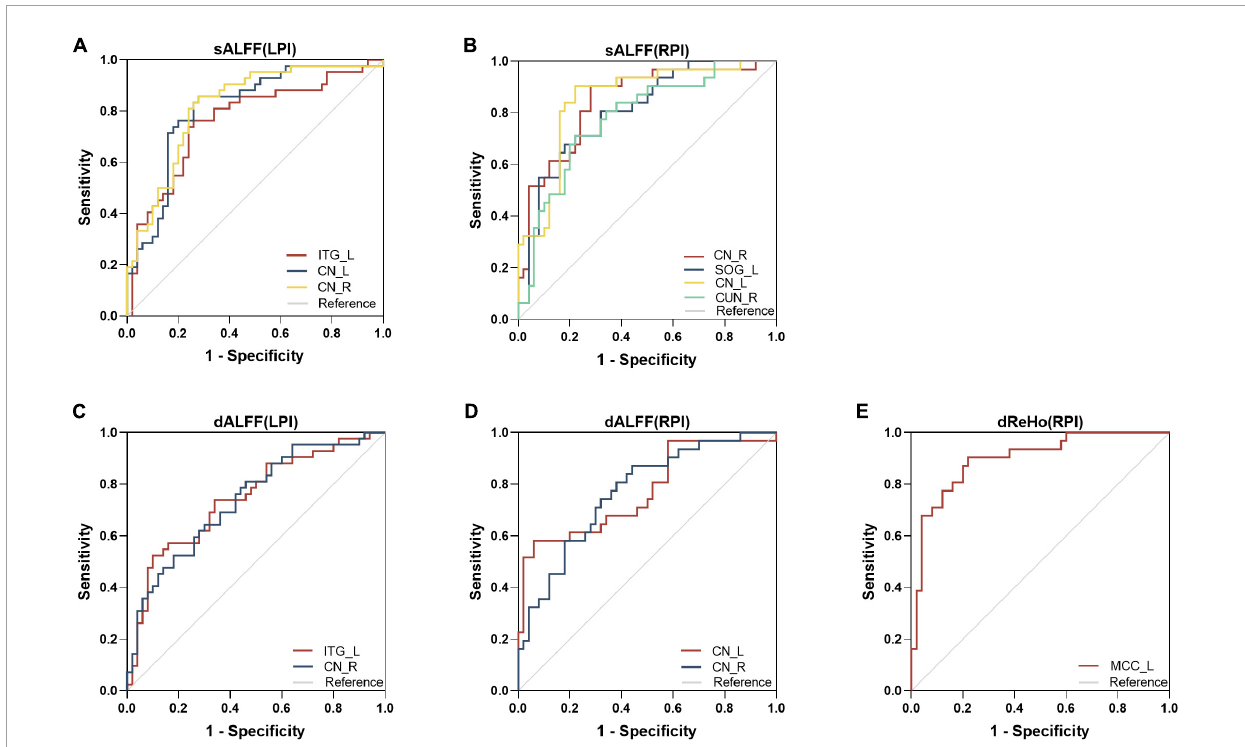
FIGURE5 Receiver operating characteristic (ROC) analyses of sALFF (A,B) , dALFF (C,D) , and dReHo (E) in the defined region of interests (ROIs). dALFF, dynamic amplitude of low-frequency fluctuations; dReHo, dynamic regional homogeneity; LPI, left pontine infarction; RPI, right pontine infarction; sALFF, static amplitude of low-frequency